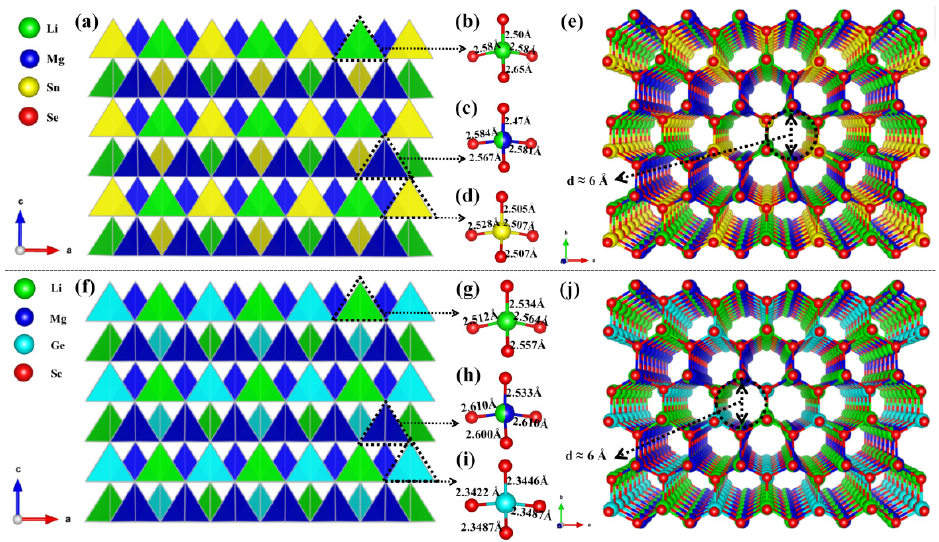
Figure 1. The DL structure of Li 2 MgSnSe 4 ( a ) and Li 2 MgGeSe 4 ( f ) on the ac plane; ( b – d , g – i ) The structures of [LiSe 4 ], [(Li/Mg)Se 4 ], [SnSe 4 ] and [GeSe 4 ] tetrahedral units. The channel-like structures of Li 2 MgSnSe 4 ( e ) and Li 2 MgGeSe 4 ( j ) on ab plane.